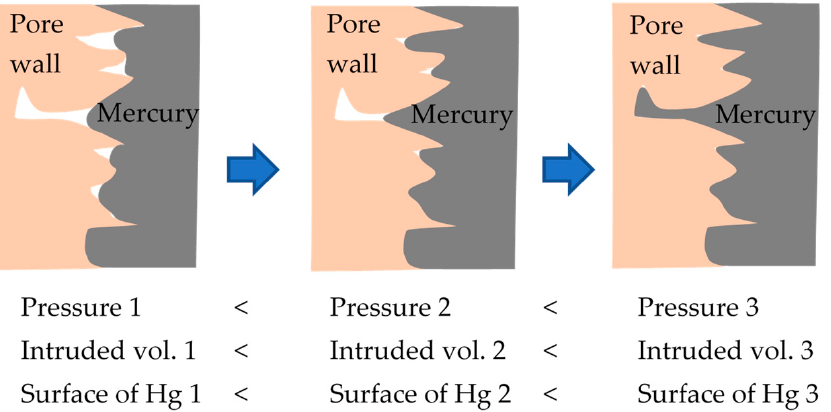
Figure 1. Correlation between pressure and the adapted surface of mercury against the rough pore wall.